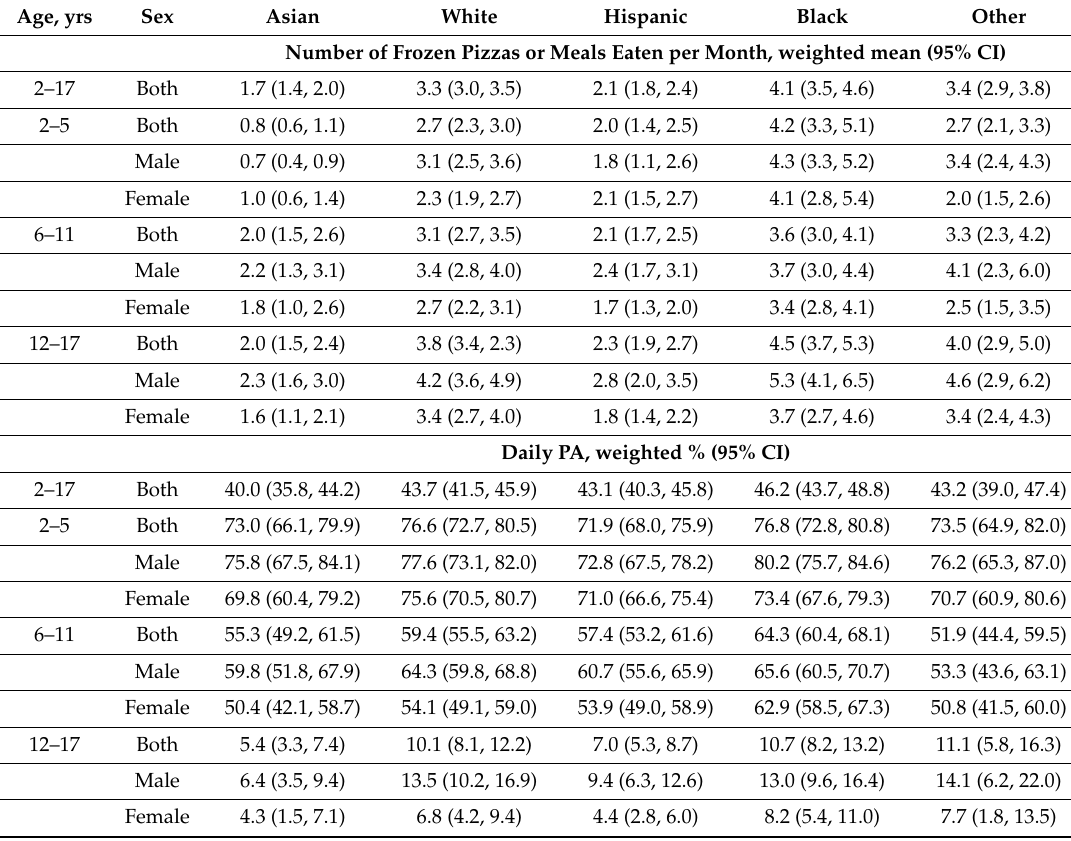
Table 5. Convenience food consumption, daily physical activity, and muscle strength by race / ethnicity. Age, yrs